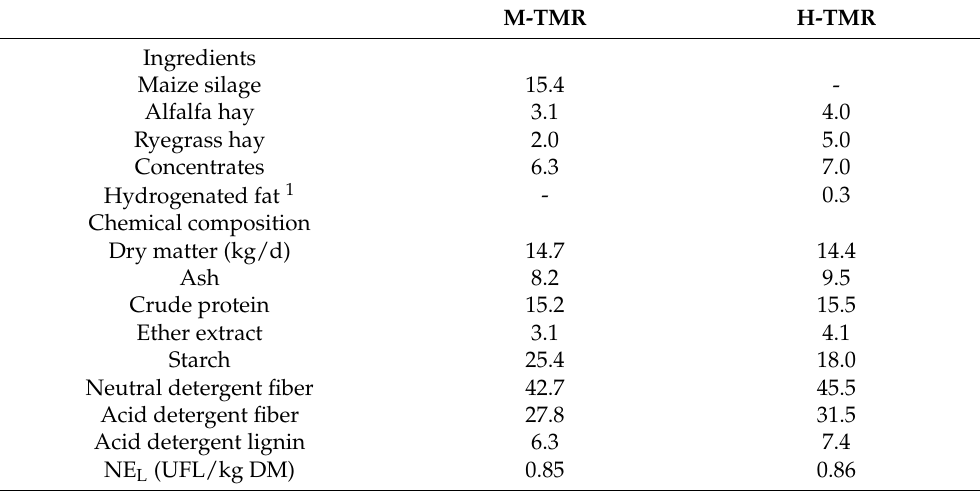
Table 1. Ingredients (kg/d as-fed) and chemical composition (% of dry matter, DM, if not otherwise stated) of the total mixed rations fed to the study